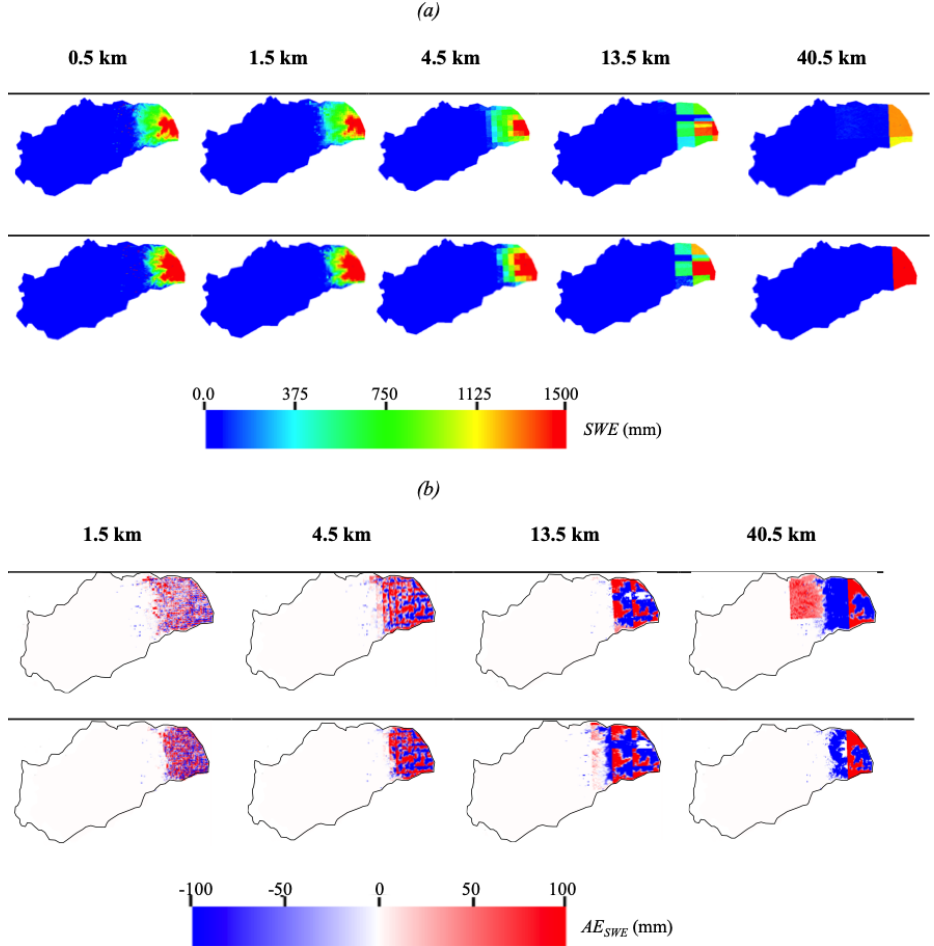
Figure 4. Spatial distributions of (a) SWE obtained with the five spatial resolutions of meteorological forcing and (b) the absolute error of SWE (AE SWE ) with respect to the highest spatial resolution of meteorological forcing (0.5km). Results are shown at WY days 125 (January) and 166